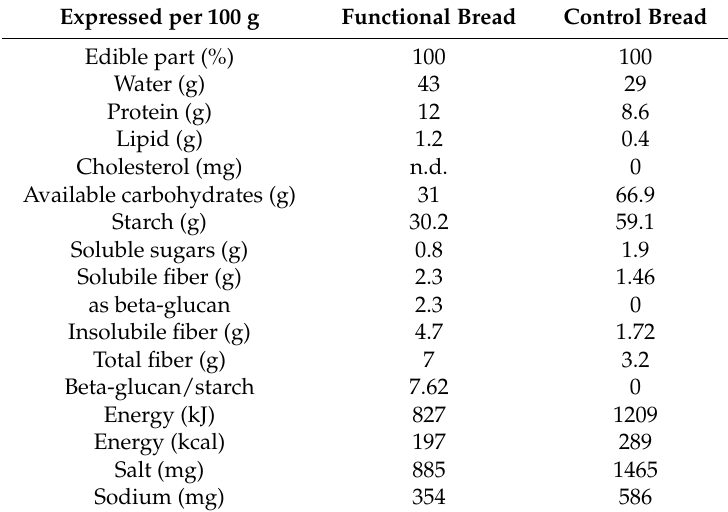
Table 1. Flour composition of the ‘functional’ and the ‘control’ (made with refined wheat white flour)